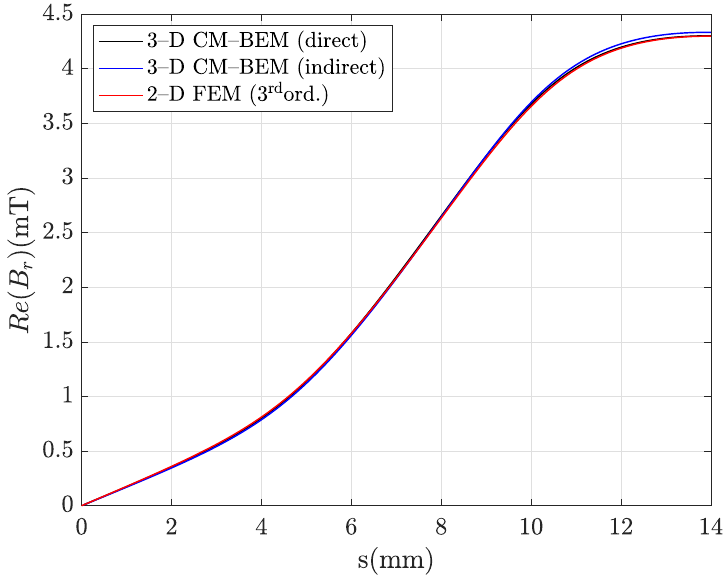
Figure 7. Real part of the radial magnetic flux density component along line C-D (black line: direct formulation, blue line: indirect formulation, red line: 2D FEM, taken as a reference).